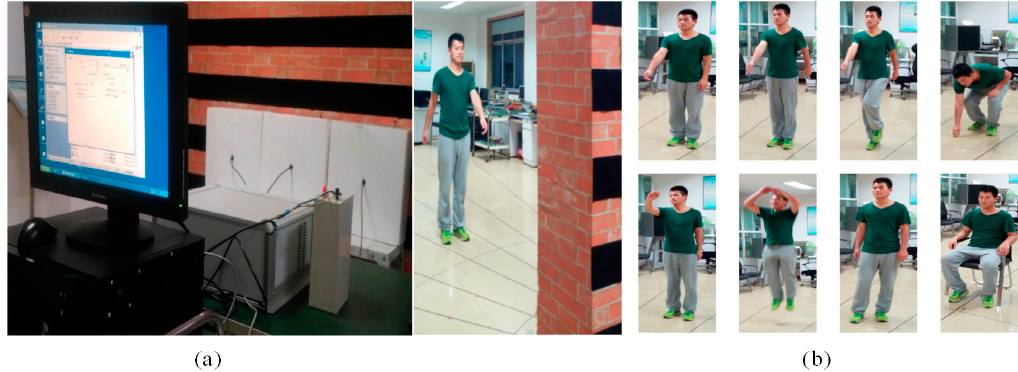
Figure 2. ( a ) SFCW radar system and experimental setup. ( b ) Eight finer-grained human activities.